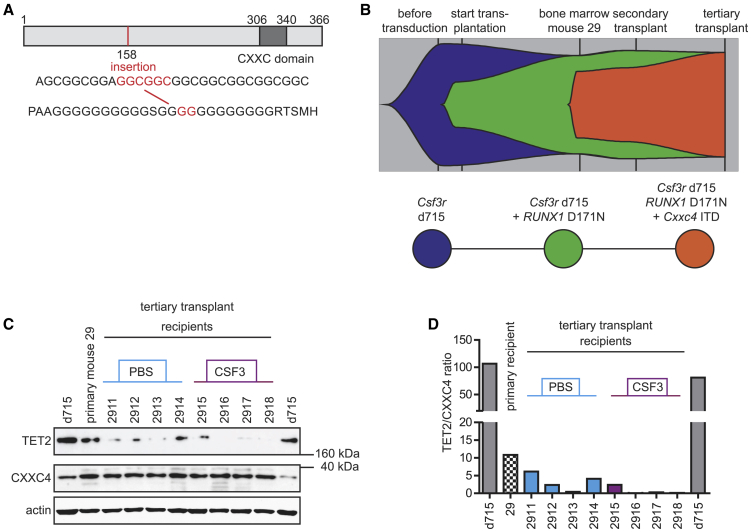
Cxxc4 Mutations and Expression of CXXC4 and TET2 Proteins in AML Cells(A) Schematic overview of the CXXC4 gene, showing acquisition of a Cxxc4-ITD in mouse leukemic cells.(B) Fish plot illustrating the clonal pattern of leukemia development.(C) Immunoblot showing elevated CXXC4 protein levels (36.44 kDa) and reduced TET2 protein levels (212.13 kDa) in pre-leukemic and leukemic samples derived from primary recipient 29 (biological replicates).(D) Quantification of TET2/CXXC4 ratios.See also Figure S4.